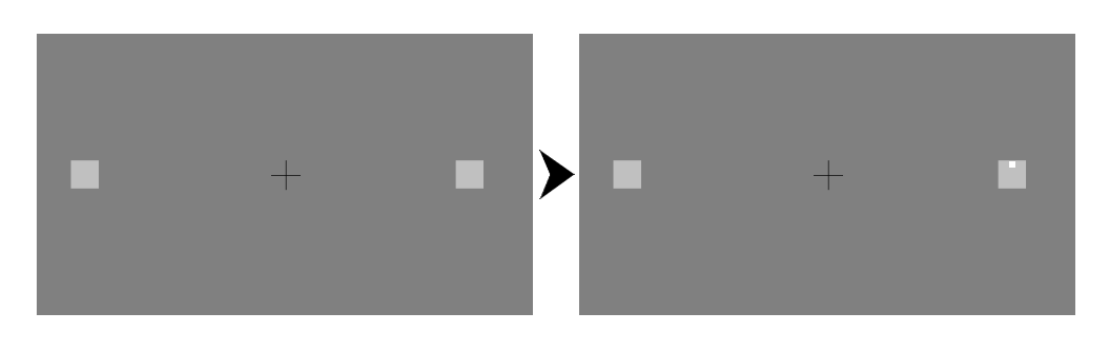
Figure 1. The setup for the visual acuity task. Each trial began with the elements in the ( left ). After the central fixation crosshair was fixated for 700 ms, the discrimination target appeared (shown in the right box in the ( right